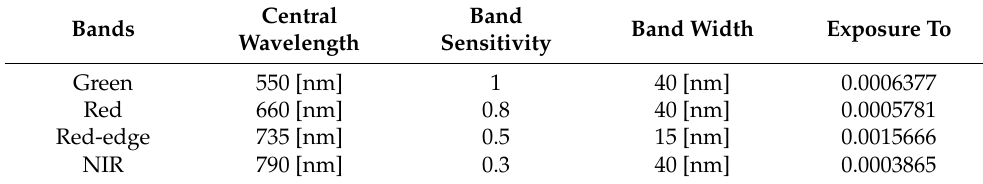
Table 1. Band characteristics of the multiSPEC 4c.